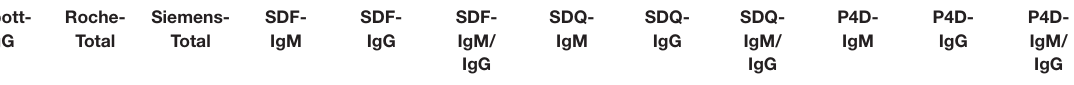
TABLE 5 | Agreement rate analysis between the SARS-CoV-2 antibody assays using agreement percentage (%), Cohen’s kappa ( κ ), and McNemar’s